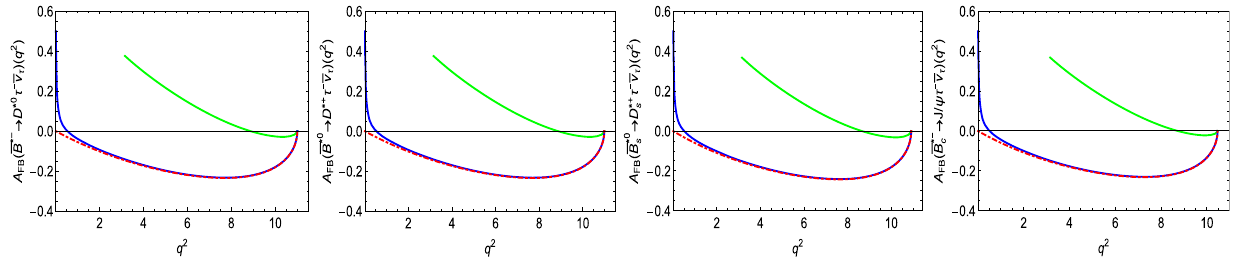
Fig. 1 The d Γ ( L ) / dq 2 as a function of q 2 for ¯ B ∗ → Vl − ¯ ν l in the SM. The red (dot dash ), blue (solid), and green (solid) lines indicate the e , μ and τ mode, respectively. The corresponding undertint represent the longitudinal differential decay rate d Γ L / dq 2 . And the same in Figs. 2, 3, 4, 5